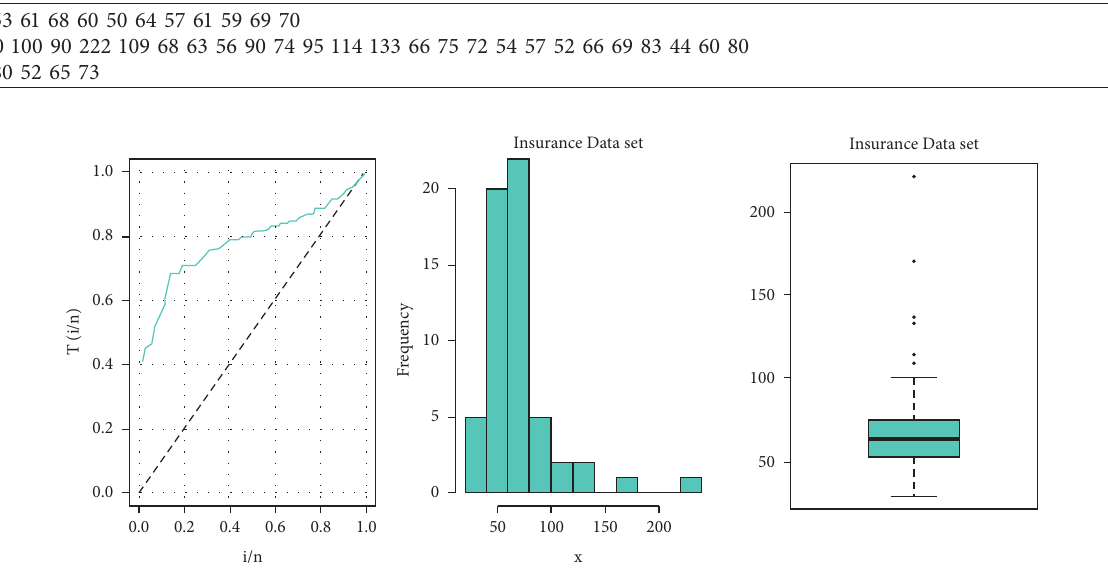
Figure 7: TTT plot, histogram, and box plots for the insurance data